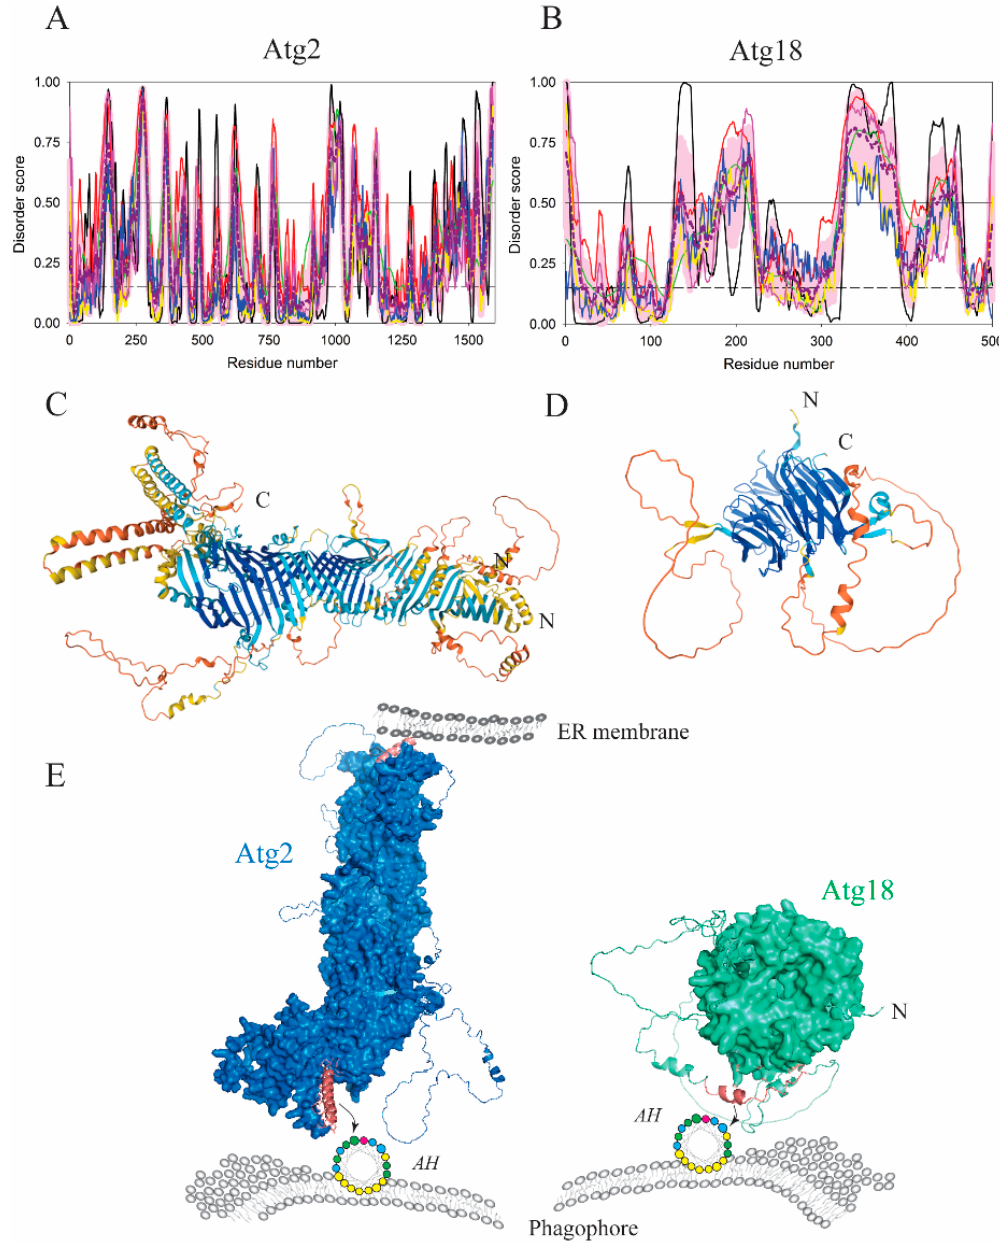
Figure 5. The Atg2–Atg18 complex is anchored to the phagophore via an amphipathic helix in each protein. ( A,B ) Bioinformatics analysis of the Atg2 and Atg18 proteins from yeast, S. cerevisiae , showed, based on the disorder score, that Atg2 is a well-folded protein with many flexible loops, whereas the Atg18 β -propeller is significantly interrupted by gaps filled by disordered regions. PONDR ® VLS2-based analysis revealed that the overall disorder contents of Atg2 and Atg18 were 29.9% and 38.8%, respectively, indicating that these two proteins are moderately disordered. ( C,D ) The AlphaFold model of Atg2 and Atg18 with color-coded modeling confidence. Very high confidence, blue; high confidence, cyan; medium confidence, yellow; low confidence, orange. ( E ) Protein surface rendering of the Atg2 and Atg18 models from C and D. The membrane-binding segments (dark pink) transition into the amphipathic α -helices in Atg2 and Atg18 that insert into the phagophore membrane. The N-terminal tip of Atg2 attaches to the ER membrane, making Atg2 a lipid transporter from the ER to the